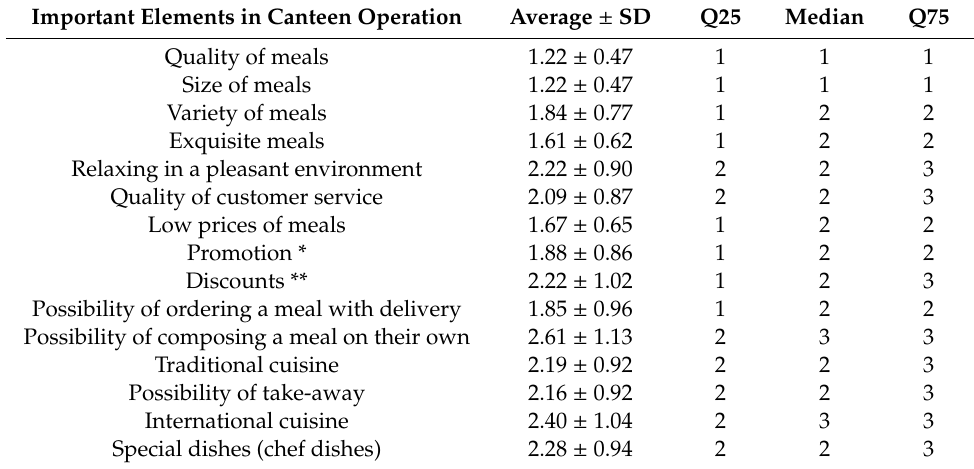
Table 3. Important elements of sta ff canteens indicated by respondents ( n =